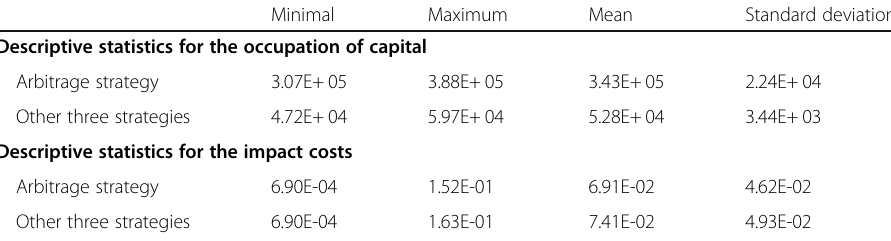
Table 4 Descriptive statistics for the occupation of capital and impact costs Minimal Maximum Mean Standard